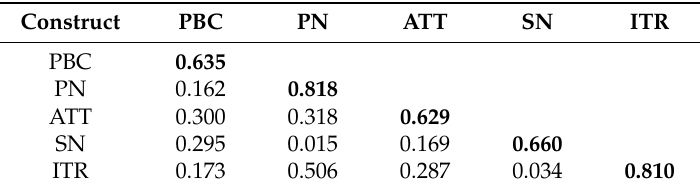
Table 4. Discriminant Validity Index Summary for the Construct.